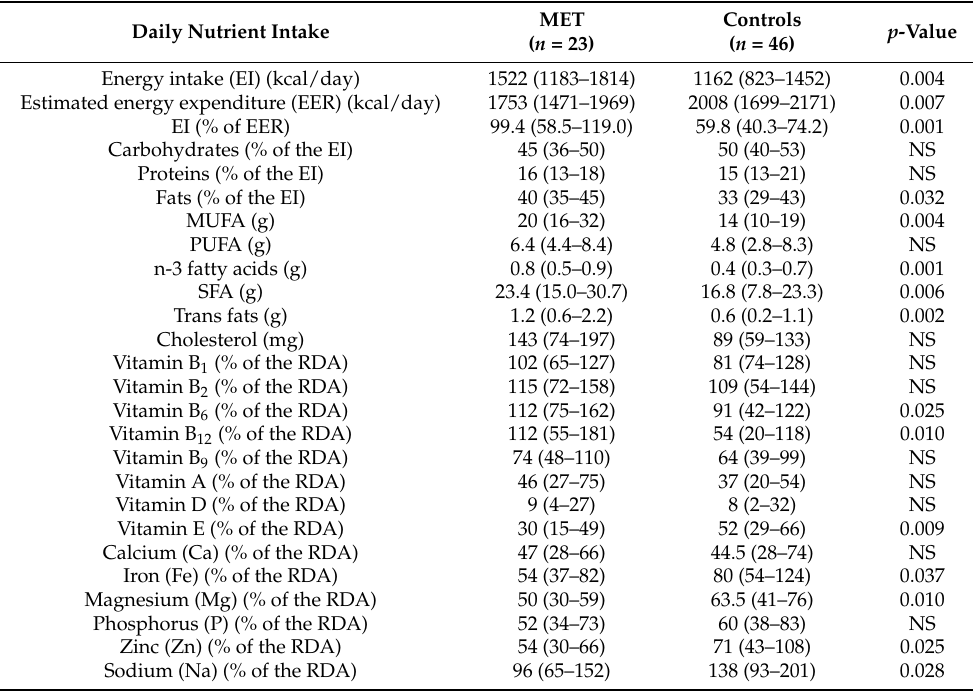
Table 2. Daily dietary intake of participating children in each arm